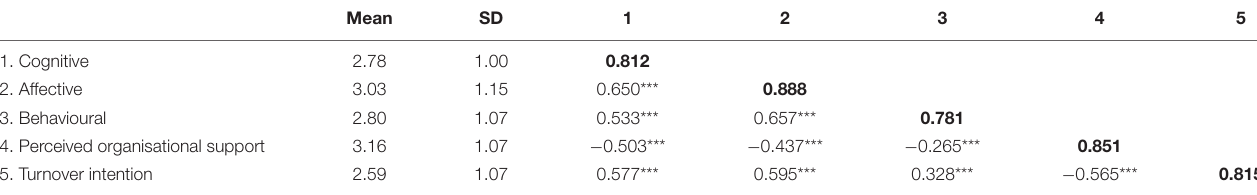
TABLE 1 | Descriptive statistics.